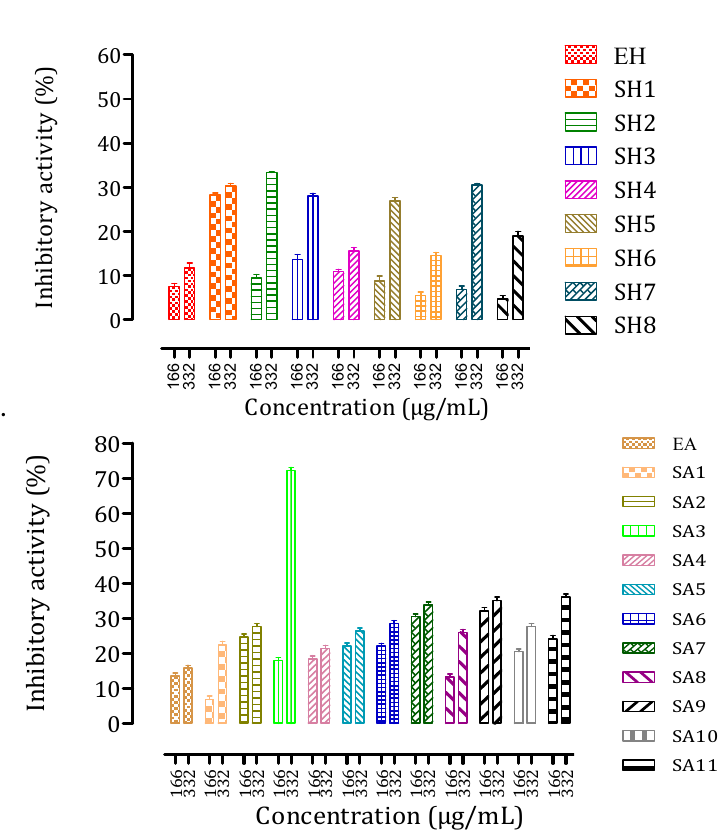
Figure 4. Inhibition of intestinal α -glucosidase by N. sativa seed ( a ) hexane extract (EH) and resulting fractions (SH1–SH8) and ( b ) acetone extract (AE) and resulting fractions (SA1–SA11) at two doses (166 and 332 µg/mL). The drug acarbose was used as a positive control at 50 µM (3.22 µg/mL) and resulted in 89.2 ± 0.5% inhibition. Extraction solvent was used as negative control (blank) and was subtracted to each corresponding extract or fraction inhibition value. Data are mean values ± standard deviation of 3 independent experiments. For mother extracts EH and EA, only a minor inhibition of intestinal α -glucosidase activity was observed (11.76 ± 1.72% and 15.84 ± 1.42%, respectively). With the concen- trations of extract or fraction added, the inhibition values generally rose, indicating the presence of at least one inhibitor of this enzyme in the considered extract/fraction. Acetone fractions showed a slightly higher inhibition compared to hexane fractions, with inhibition percentages ranging from 14.60 ± 1.12% (SH6) to 33.37 ± 0.31% (SH2) for hexane fractions and from 21.44 ± 1.54% (SA1) to 72.26 ± 1.42% (SA3) for acetone fractions. Polyphenolic compounds were more abundant in acetone fractions than in hexane fractions. The most active acetone fraction, SA3, was particularly rich in ( − )-catechin and gallic acid. Several phenolics, including gallic acid and ( − )-catechin, have been found to inhibit intestinal α -glucosidase, which supports this observation [8–10,41–44].